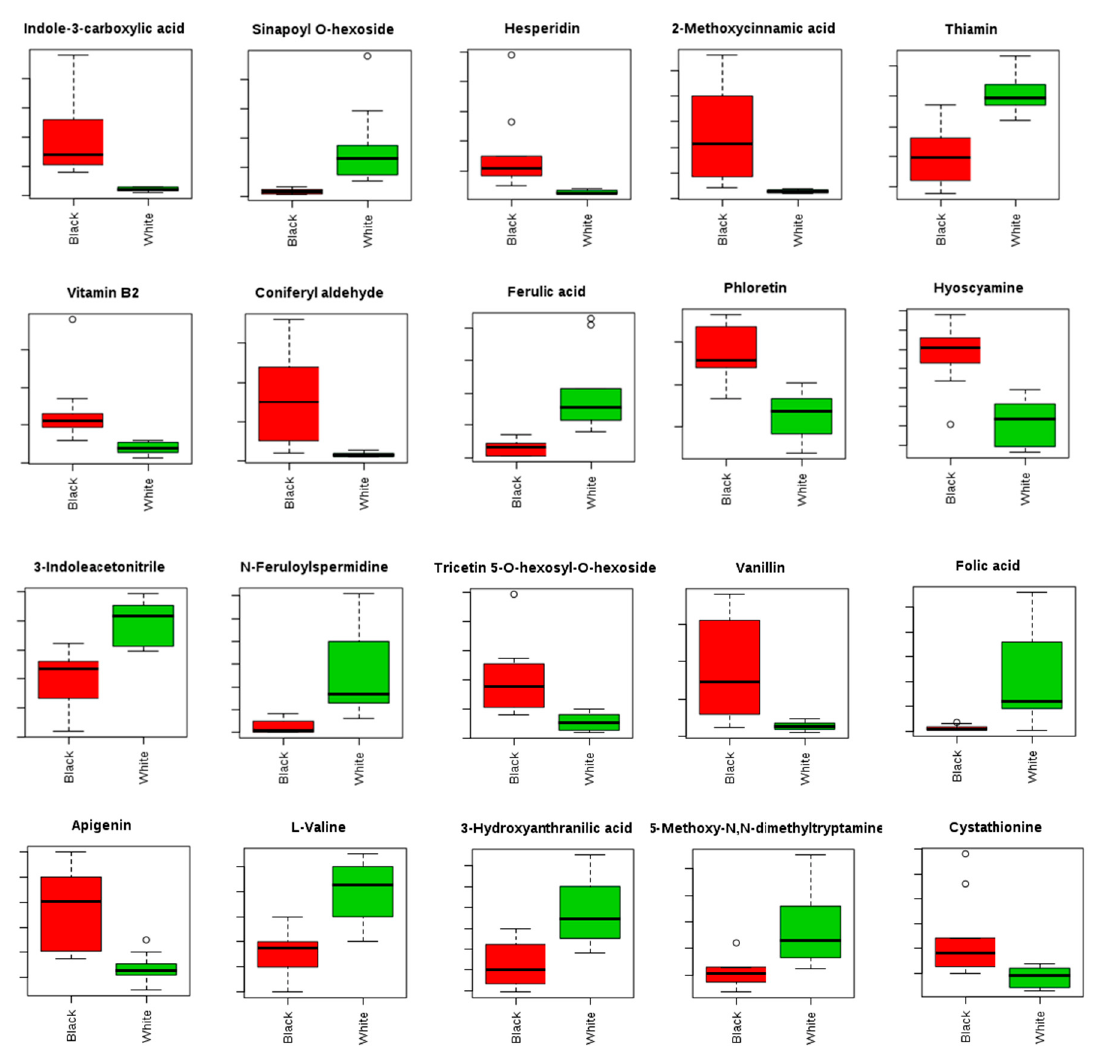
Figure 3. Differences in the contents of 20 metabolites in black (left) and white (right) sesame seeds.